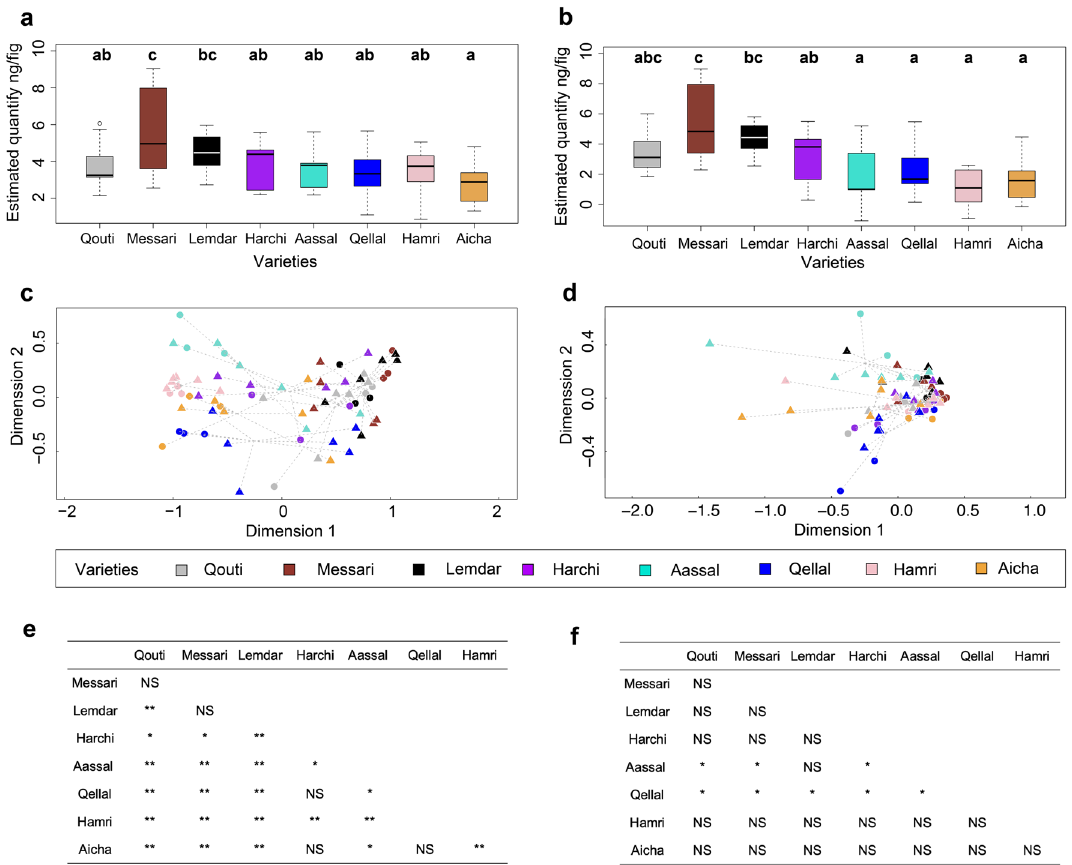
Figure 2. Comparison among the eight varieties of Ficus carica of the total estimated quantities and relative proportions of volatile organic compounds (VOCs) emitted by receptive figs. The box plot of estimated total quantifies (log-transformed) of all VOCs ( a ) and of the four pollinator-attractive VOCs ( b ) are presented, together with the results of pairwise comparisons of estimated total quantities within each variety using least-squares means comparisons. Different letters indicate statistically significant differences. Non-metric multidimensional scaling ordination (NMDS) of the relative proportions based on Bray–Curtis distance are presented for all VOCs ( c , Stress = 0.113) and for the four pollinator-attractive VOCs ( d , Stress = 0.066) (circle: 2017, triangle: 2018). In addition, results of pairwise comparisons of the relative proportions using PERMANOVA are presented for all VOCs ( e ) and for the four VOCs responsible for pollinator attraction ( f ). p < 0.01: ** p < 0.05: * p > 0.05: p < 0.001, Fig. 2c). For the four attractive VOCs, whereas relative proportions varied significantly among varieties and between years, there was no significant effect of the interaction of these two factors (respectively F 7,70 = 4.23,